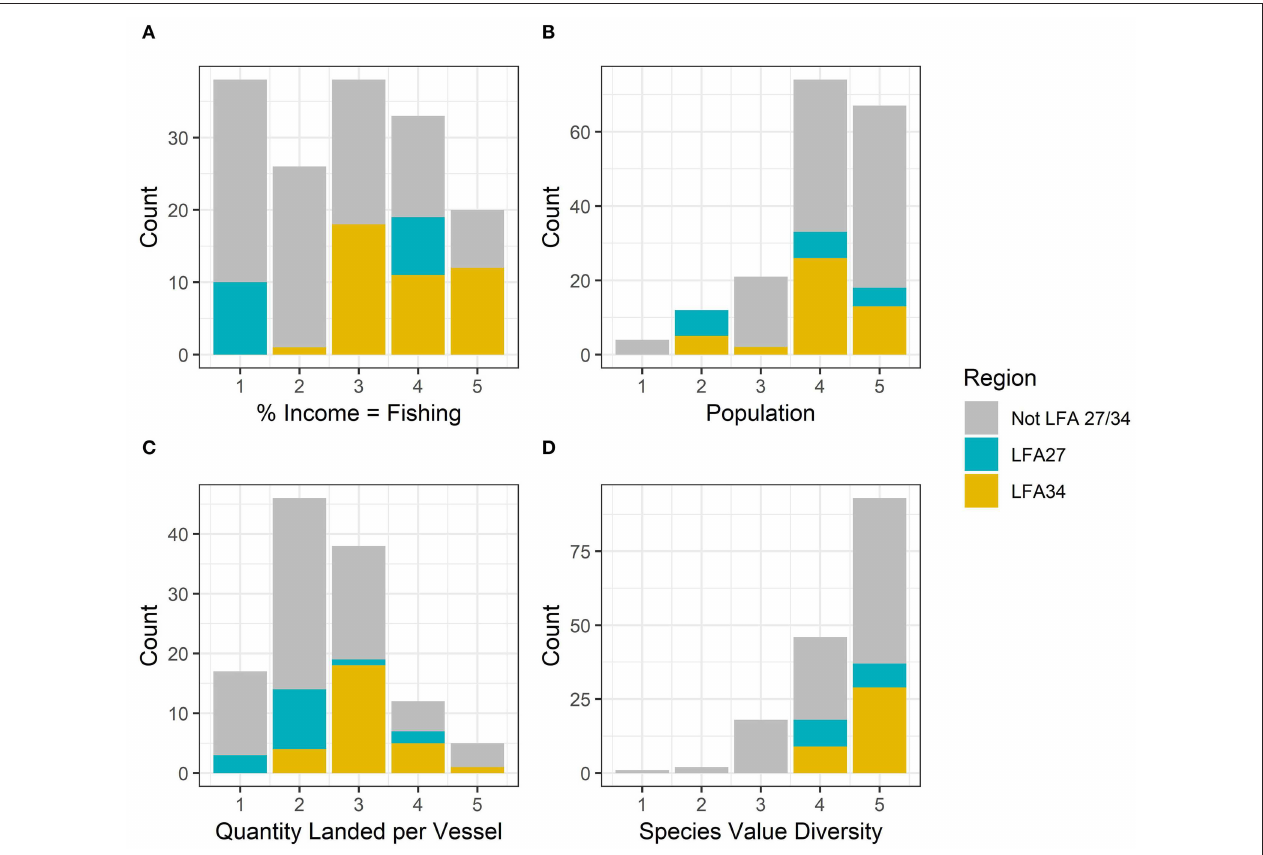
FIGURE 8 | Distribution of scores for the Socio-Economic Sub-Index (SESI) variables and Species Value Diversity (SVD) for three groupings of Small Craft Harbors: LFA 27, LFA 34, and all other LFAs. (A) Percent income from fishing, (B) Population, (C) Quantity Landed per Vessel, and (D) Species Value Diversity